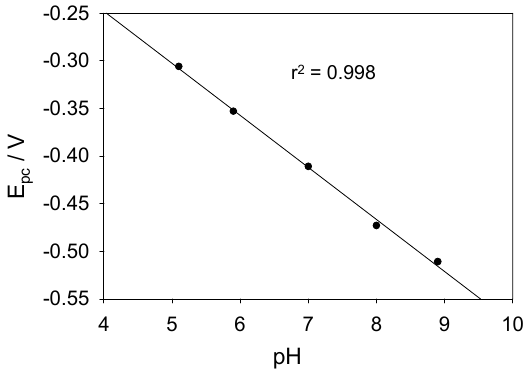
15. The variation of the cathodic peak potential with pH obtained using a SWCNT/GOx/Nafion-modified gold working electrode in buffers of various pH values. The sweep rate employed in each case was 100 mVs -1